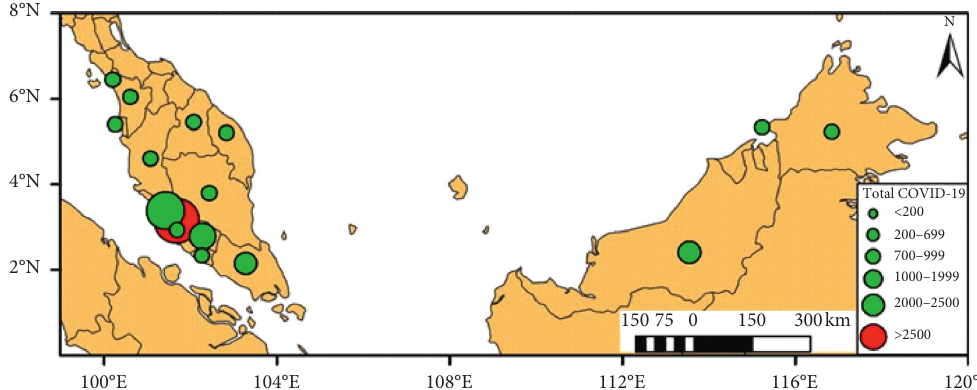
Figure 1: COVID-19 cumulative confirmed cases across states and cities in Malaysia as of 31 August 2020. Kuala Lumpur’s cumulative case is classified as the red